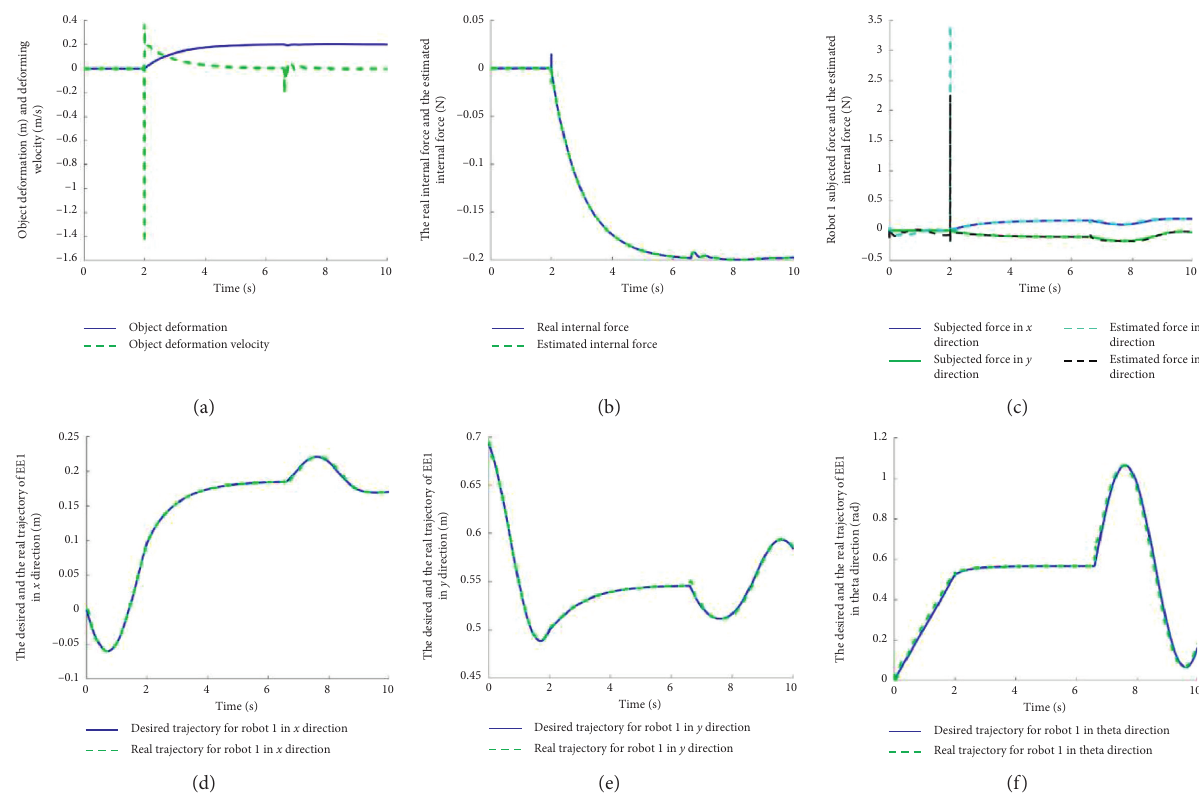
Figure 6: Some changing variables in Case 1, including object deforming information, internal force, estimated forces, and EE trajectories.